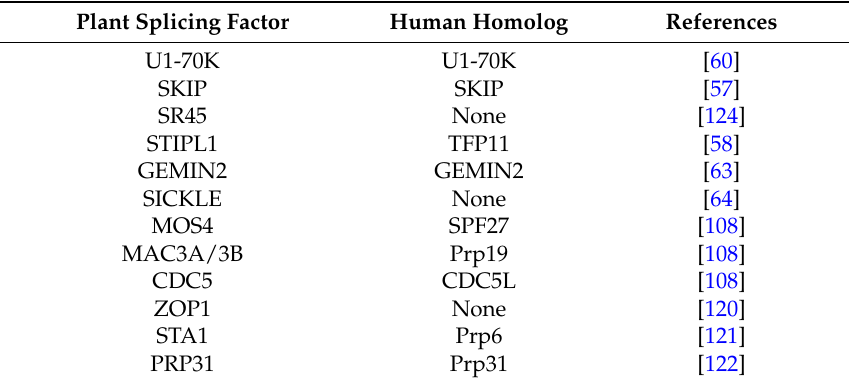
Table 1. Plant splicing factors and their human homologs. Plant Splicing